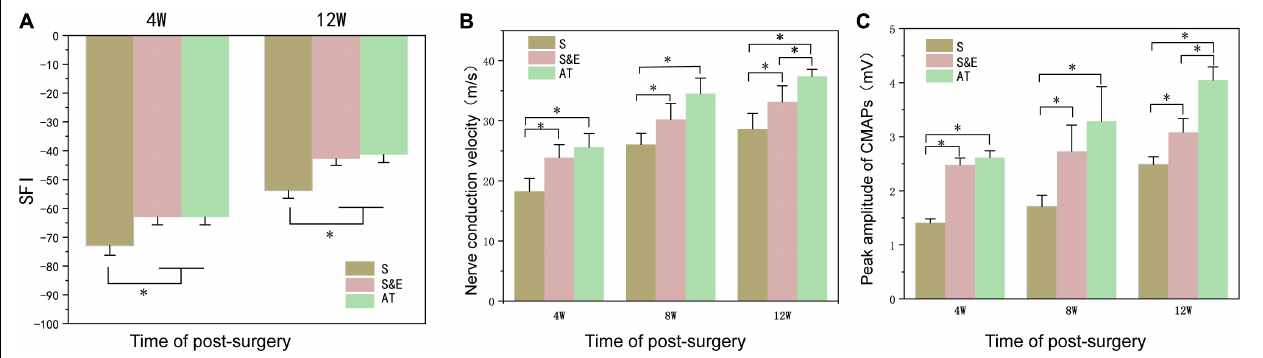
FIGURE 6 | (A) At weeks 4 and 12, SFI values of Group S were lower than those of Group AT and Group S&E ( n = 5, ∗ p < 0.05). There was no significant difference in SFI values between Group AT and Group S&E. (B,C) The nerve conduction velocity of regenerated nerves and the peak amplitude of CMAP of the gastrocnemius muscle at the 4th, 8th, and 12th weeks after implantation ( n = 5, ∗ p < 0.05). SFI, sciatic functional index; CMAP, compound muscle action potential.